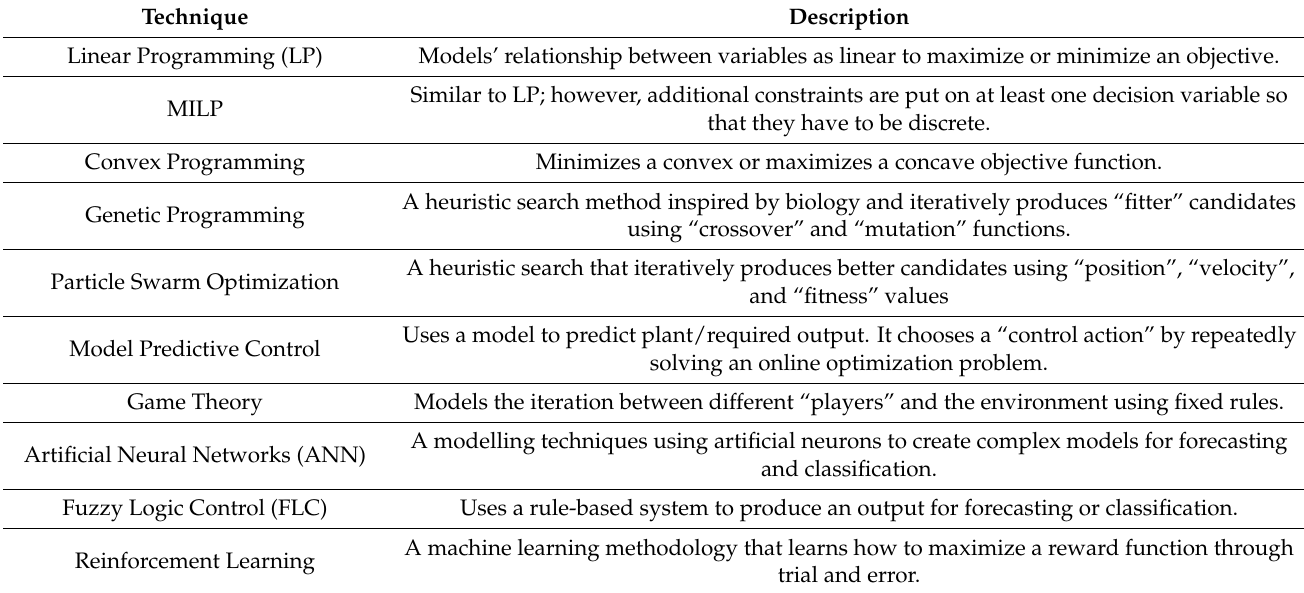
Table 1. Description of scheduling techniques